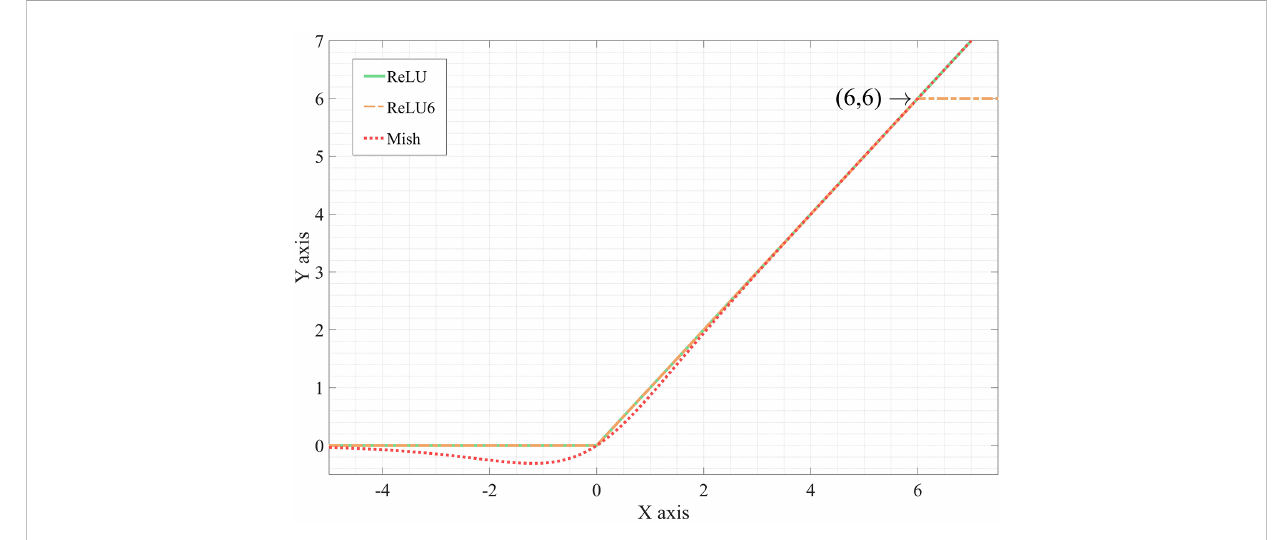
FIGURE 2 Comparison between ReLU, ReLU6, and